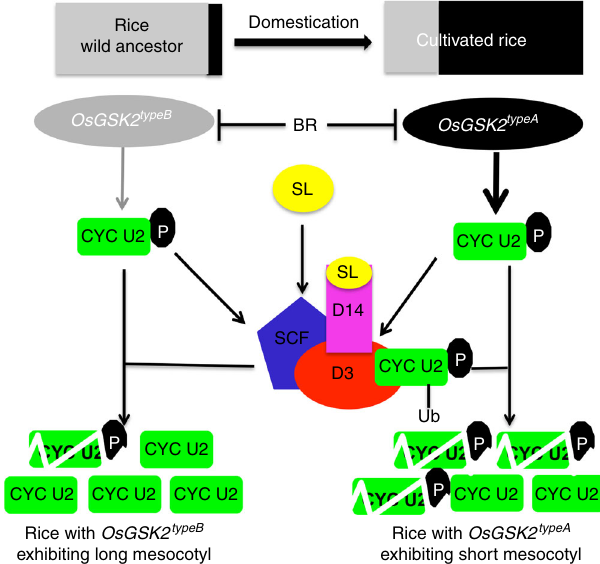
Fig. 6 A proposed working model for mesocotyl elongation and domestication. Gray indicates OsGSK2 typeB with low kinase activity, and black indicates OsGSK2 typeA with high kinase